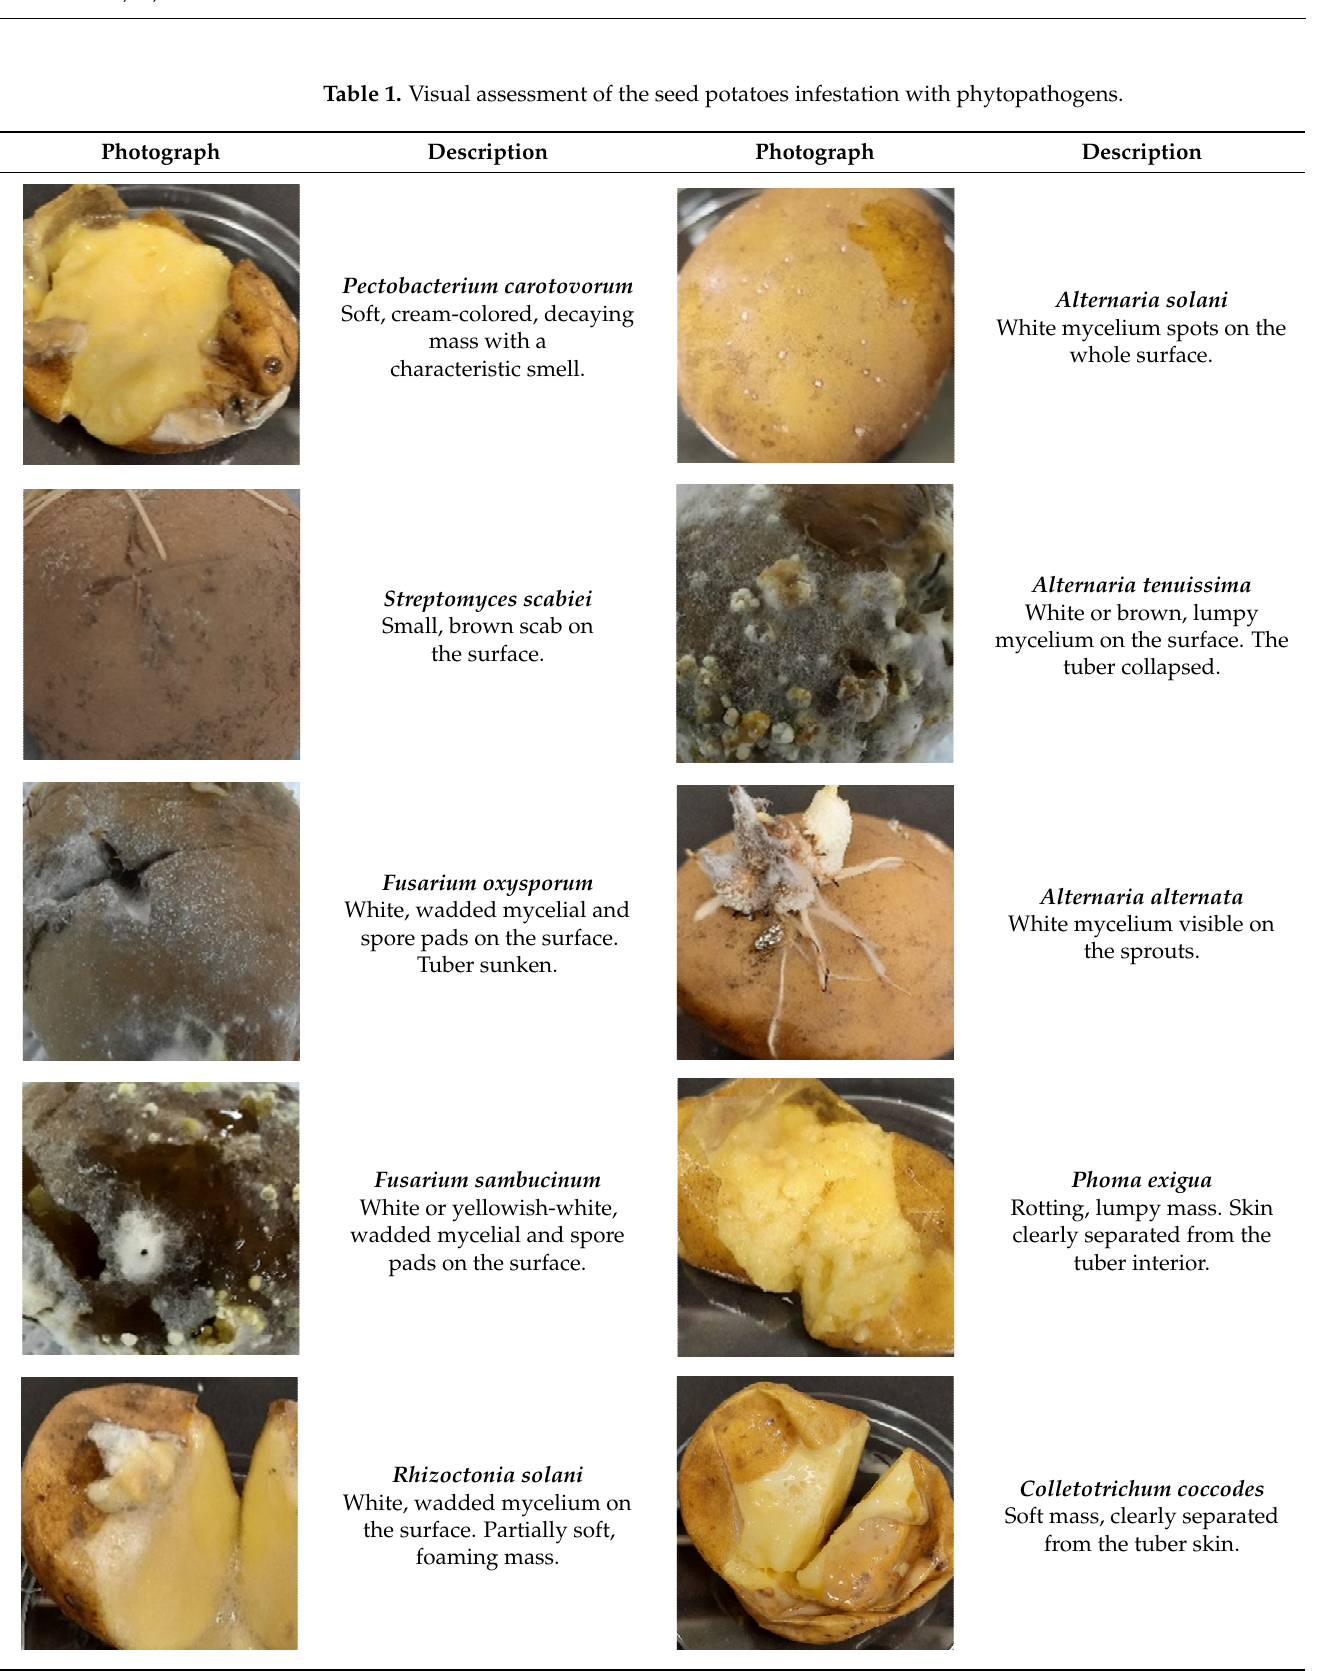
ble on the sprouts.